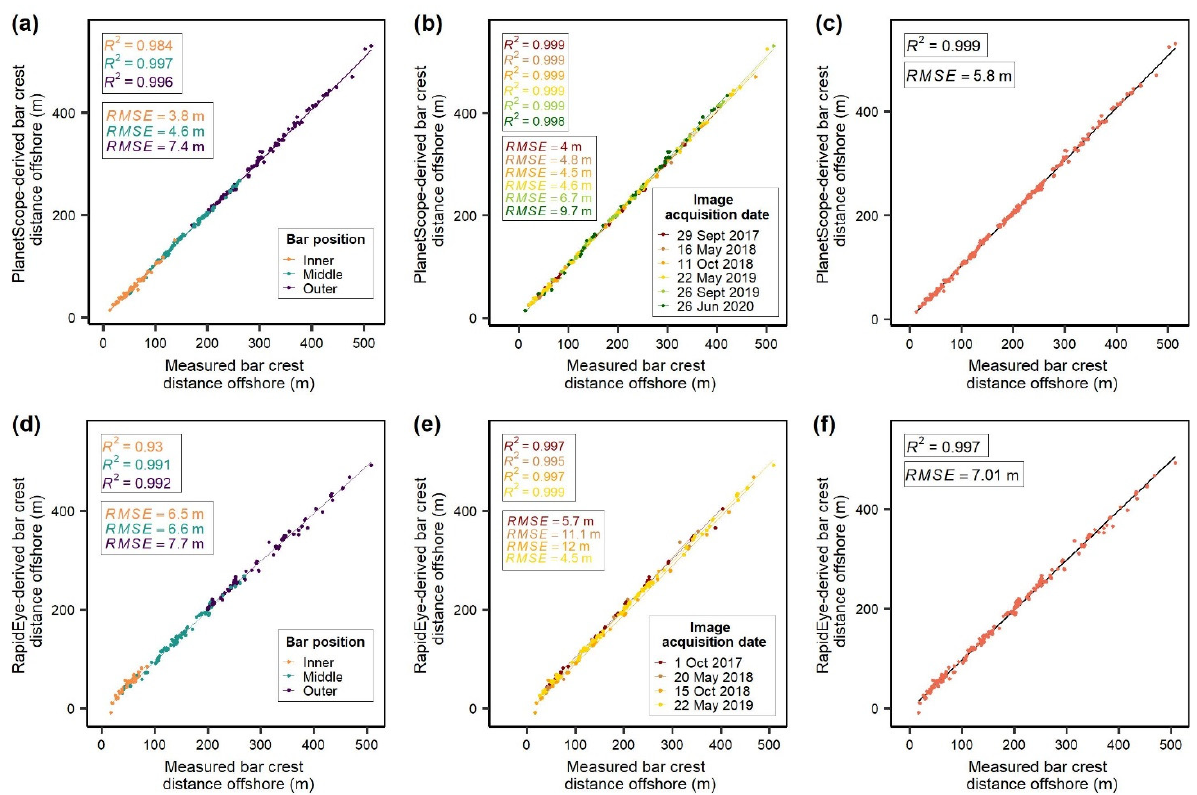
Figure 10. Correlation between measured and satellite-derived sandbar crest positions: ( a – c ) PlanetScope; ( d , e ) RapidEye. Column 1 ( a , d ) shows correlation for inner, middle and outer sandbars; column 2 ( b , e ) shows correlation for dates of image acquisition, column 3 ( c , f ) shows total correlation and root-mean-square-error for analysed sensors.